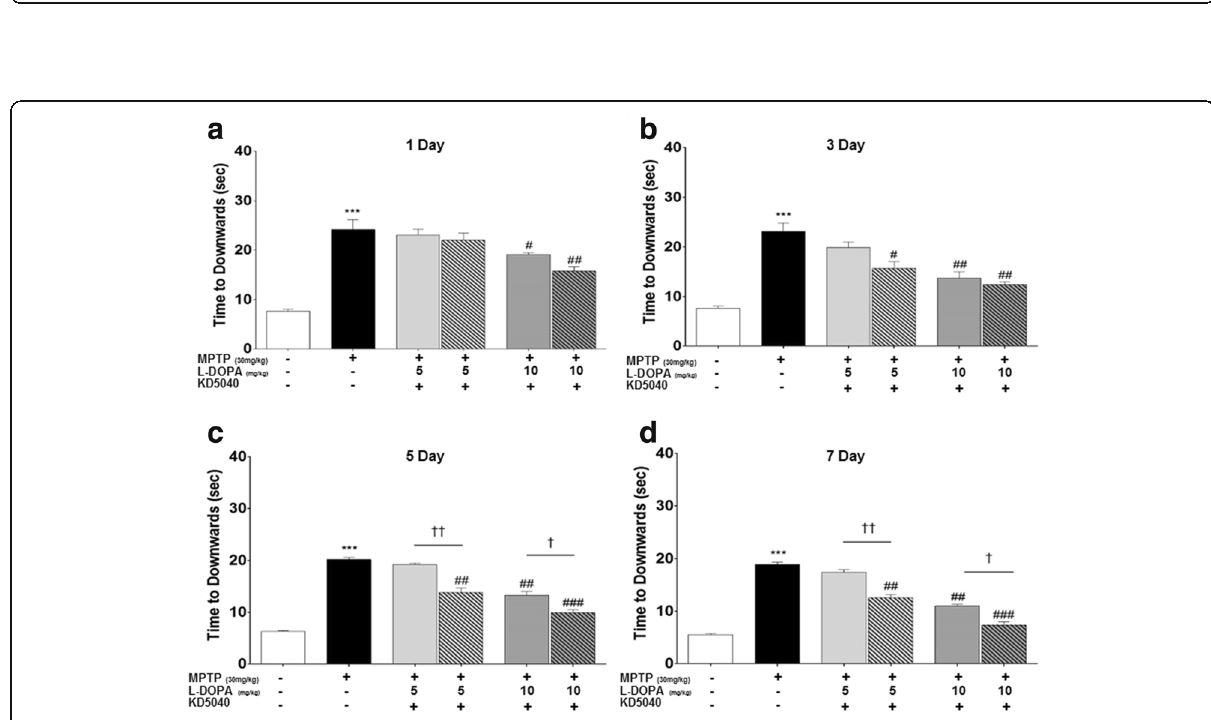
Fig. 4 Effects of combination treatment on days 1 ( a ), 3 ( b ), 5 ( c ), and 7 ( d ) after first treatment with KD5040 based on the pole test. KD5040 in combination with -dopa (LL and ML) reduced time to descend compared to the respective doses of -dopa alone. C: control, M: MPTP, K: L L -dopa (5 mg/kg), ML: medium dose of -dopa (10 mg/kg). *** p < 0.001, ** p < 0.01, and * p < 0.05 vs. control, ### KD5040, LL: low dose of L L p < 0.001, ## p < 0.01, and # p < 0.05 vs. MPTP, and ††† p < 0.001, †† p < 0.01, and † p < 0.05 vs. each dose of L